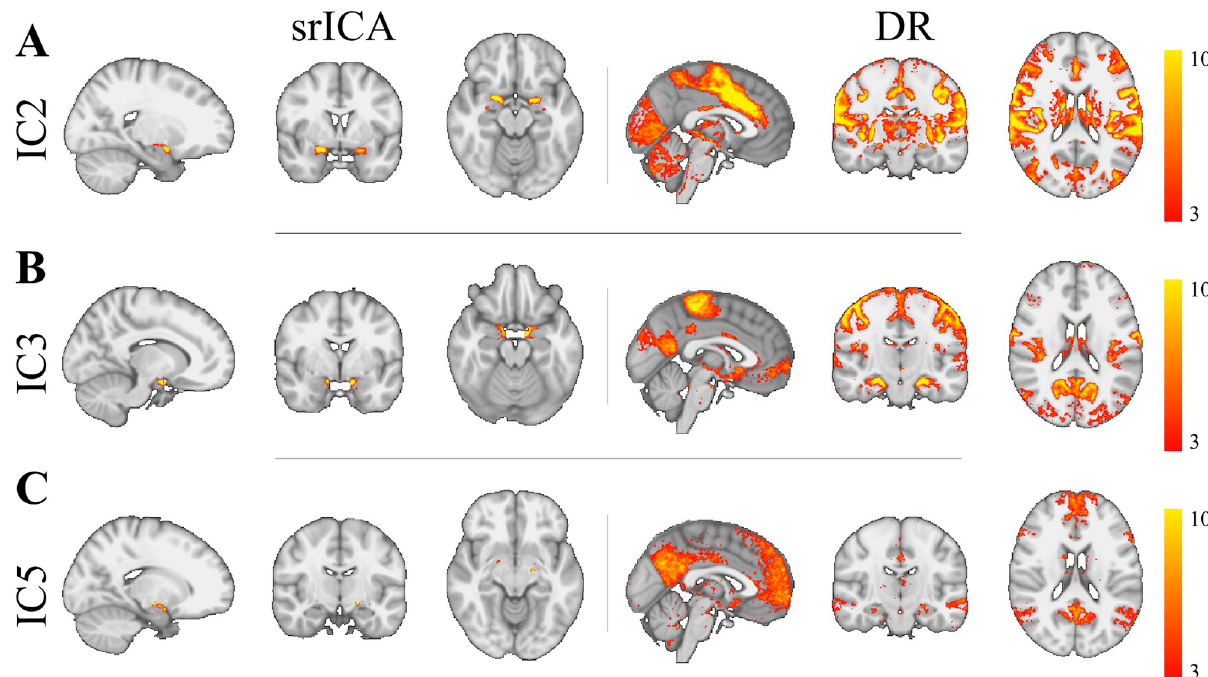
Fig 3. Results from srICA and dual regression. srICA left colum and Dual Regression right column. A: IC2 (Ventral Attention), B: IC3 (Somatomotor), C: IC5 (Default Mode). Note how different IC hotspots inside the amygdala connect to separate whole brain networks.